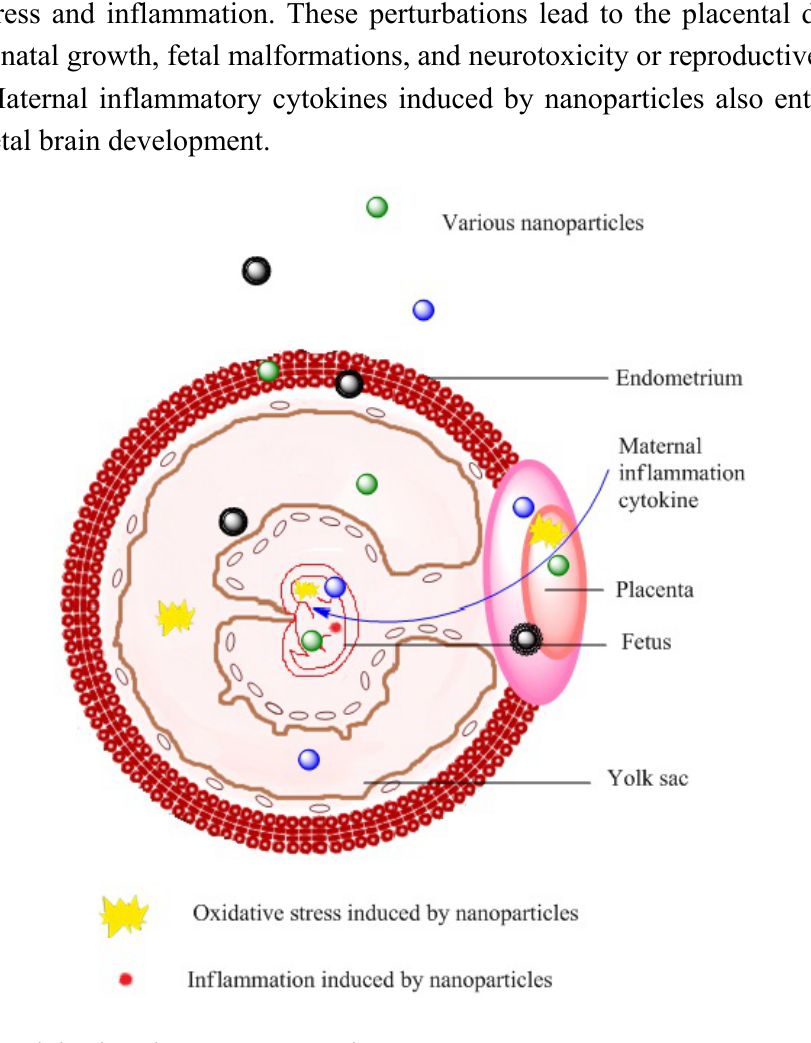
Figure 1. Neonatal toxicity as a result of nanoparticle exposure to pregnant